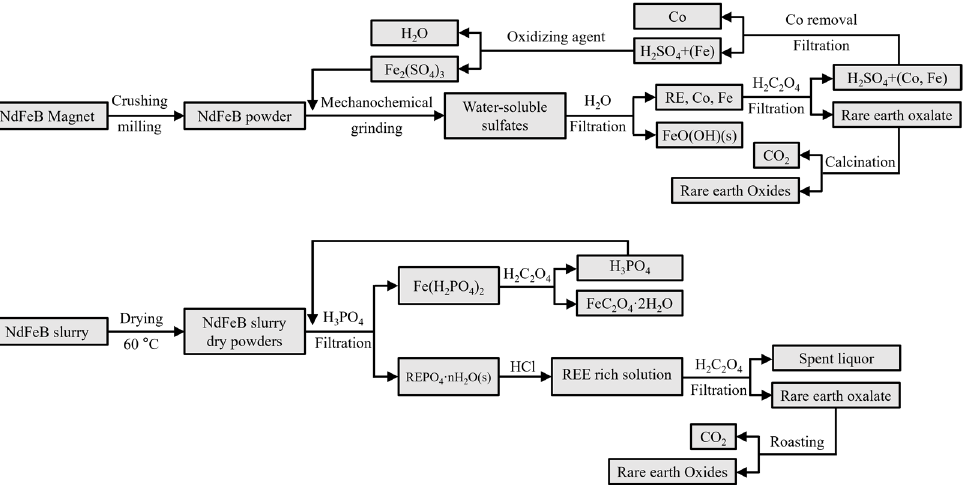
Figure 6. The typical technical flow chart of the H 2 C 2 O 4 precipitation method.